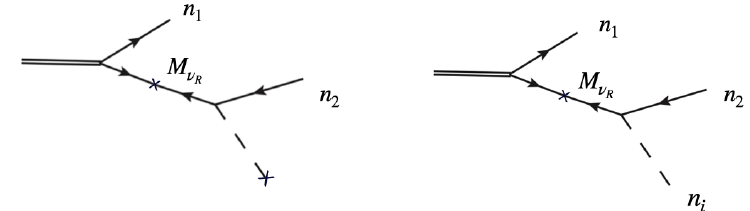
Figure 4 . Tree-level Feynman diagrams involving a Majorana mass insertions on the neutrino propagator in models with a heavy right-handed neutrino. A double line represents the leptoquark, a dashed line with a cross the Higgs vacuum expectation value, and a dashed line a Higgs boson. The final-state particle moving along n 1 is a quark, while the particle moving along n 2 is a lepton. The Higgs bosons can move in either